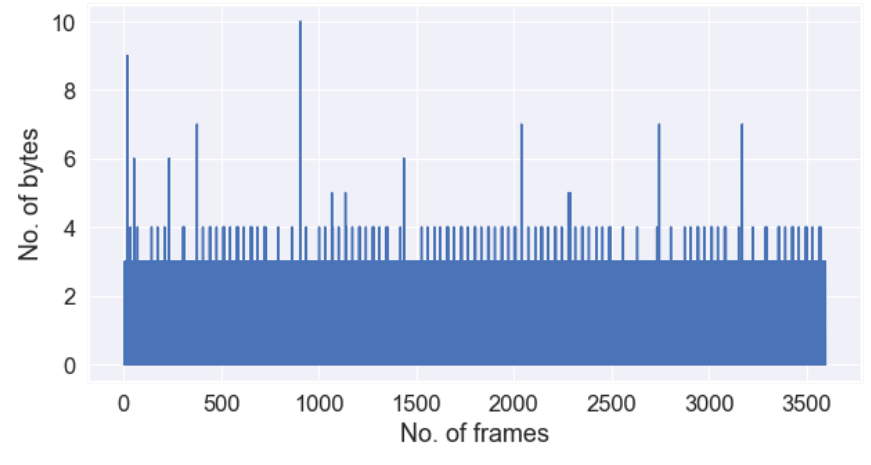
Figure 16b. I/O write requests S2.1.